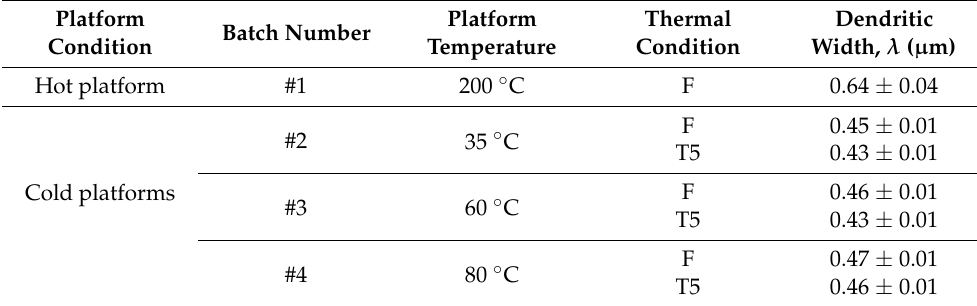
Table 3. Average dendritic width parameter of AlSi7Mg